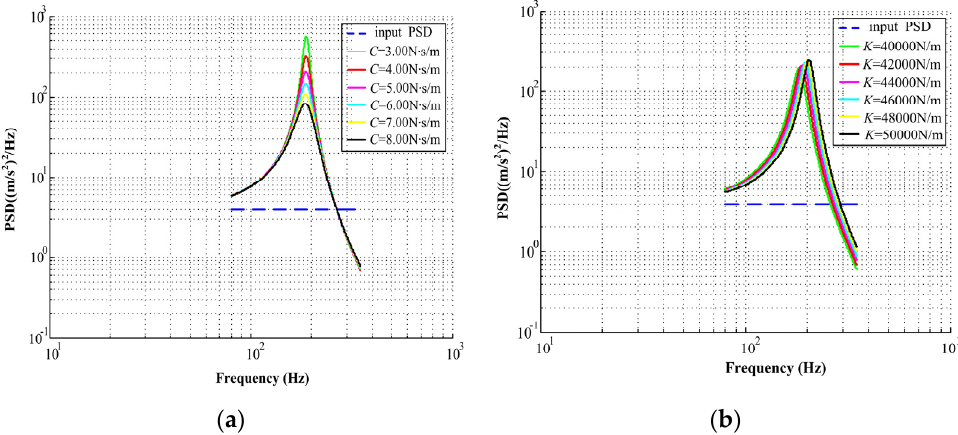
Figure 6. ( a ) Random vibration response curve under different axial damping; ( b ) random vibration response curve under different axial stiffness.